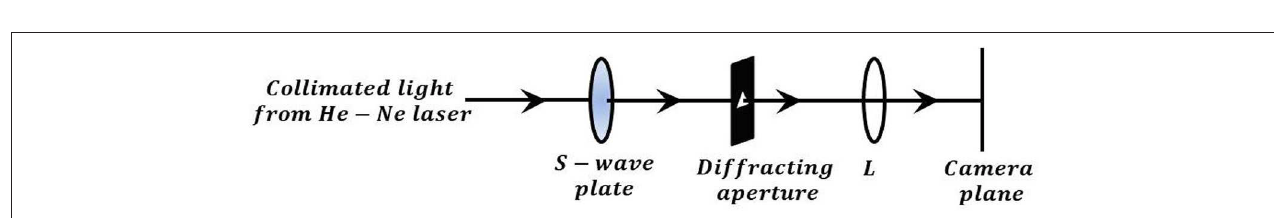
FIGURE 13 | Schematic of setup for diffraction through aperture: S-waveplate-spatially varying half waveplate; Diffracting triangular aperture; L - lens; Camera plane.